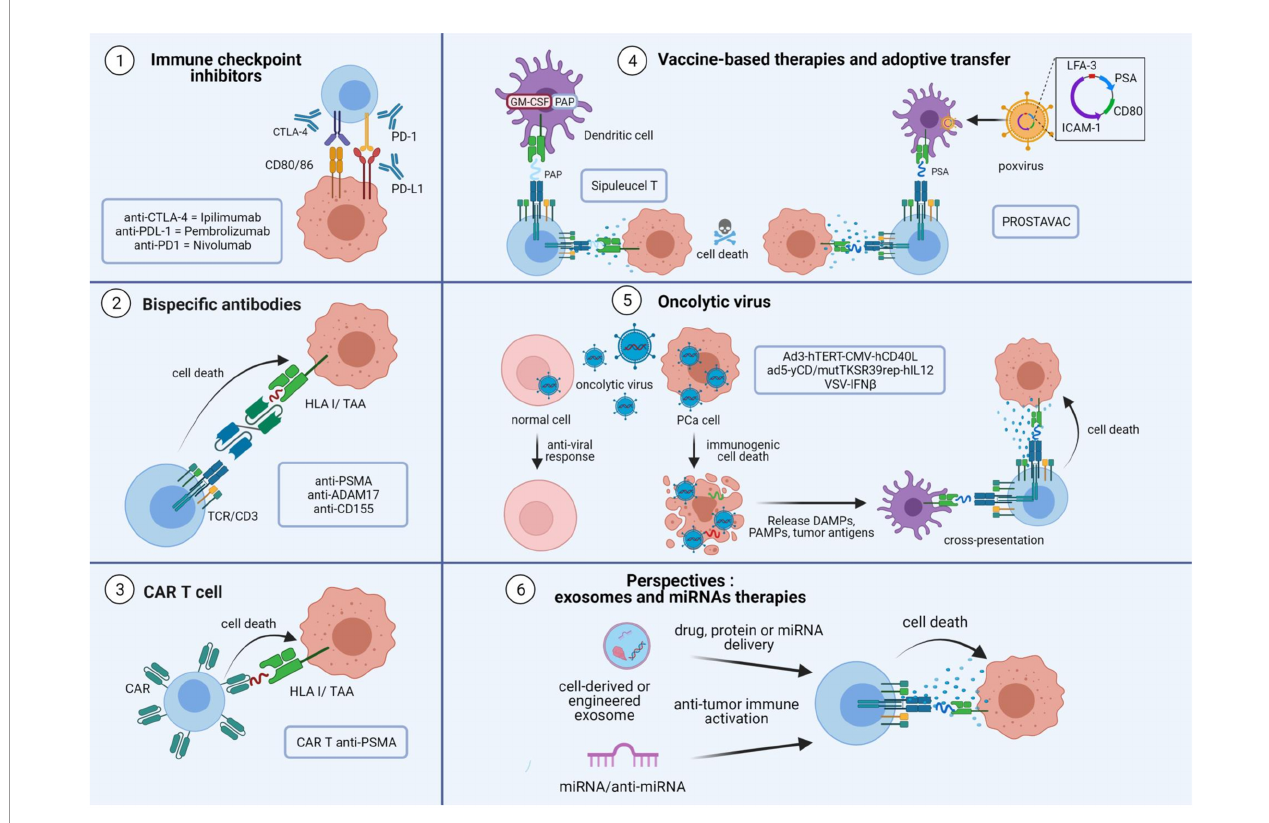
FIGURE 2 | Overview of immunotherapies and perspectives in prostate cancer. The aim of immunotherapies for prostate cancer is to activate tumor-speci fi c CD8+ T cells to induce tumor cell death. The tumor microenvironment induces the expression of immune inhibitory signaling pathways to decrease the cytotoxic CD8+ T cell response. Immune checkpoint inhibitor antibodies directed against PD-L1, PD-1 and CTLA-4 are used to avoid T cell exhaustion. Bispeci fi c antibodies consist of an effective arm that targets the CD3 protein and a target arm that recognizes the tumor antigen. This technology helps CD8+ T cells interact with tumor cells to induce their death. Personalized therapies are also being developed. CD8+ T cells from patients could be manipulated to express a chimeric antigen receptor directed against a speci fi c antigen, notably TAAs. The cells are then expanded and reinjected into the patient, to selectively destroy target cells harboring the surface epitope of interest. Viral and non-viral vectors are used to increase the antigen loading of dendritic cells, leading to an increase in CD8+ cytotoxic T cells in the tumor and response. Enhanced immunotherapy is achieved by the use of oncolytic viruses engineered to replicate only in tumor cells and kill them to induce immunogenic cell death. The use of exosome and microRNA therapies are promising approaches as exosomes and microRNAs are involved in tumor escape. The use of engineered exosomes to deliver proteins, drugs or miRNAs are options to improve anti-tumor response in prostate cancer. TAA, tumor-associated antigen; TCR, T cell receptor; PSMA, prostate speci fi c membrane antigen; CAR, chimeric antigen receptor; PSA, prostate speci fi c antigen; PAP, prostatic acid phosphatase; PCa, prostate cancer; DAMPs, damage-associated molecular patterns; PAMPs, pathogens associated molecular patterns; VSV, vesicular stomatitis virus; MVE, multivesicular